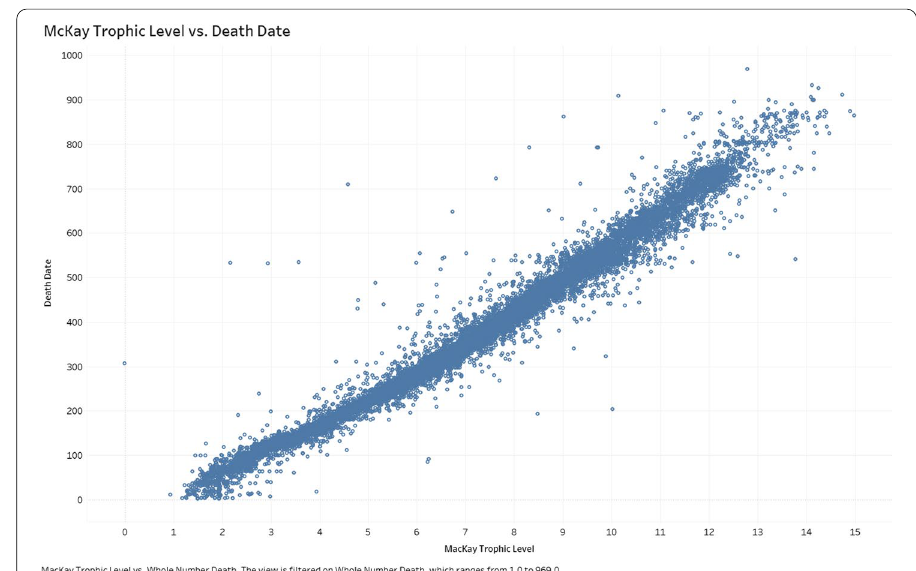
Fig. 5 Generalised trophic level plotted against the death dates of the